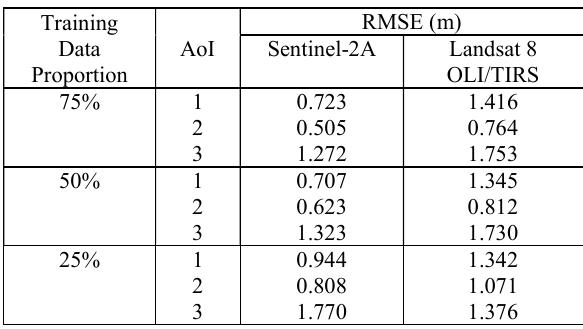
Table 2. The RMSE values when performing GWR on various data set.